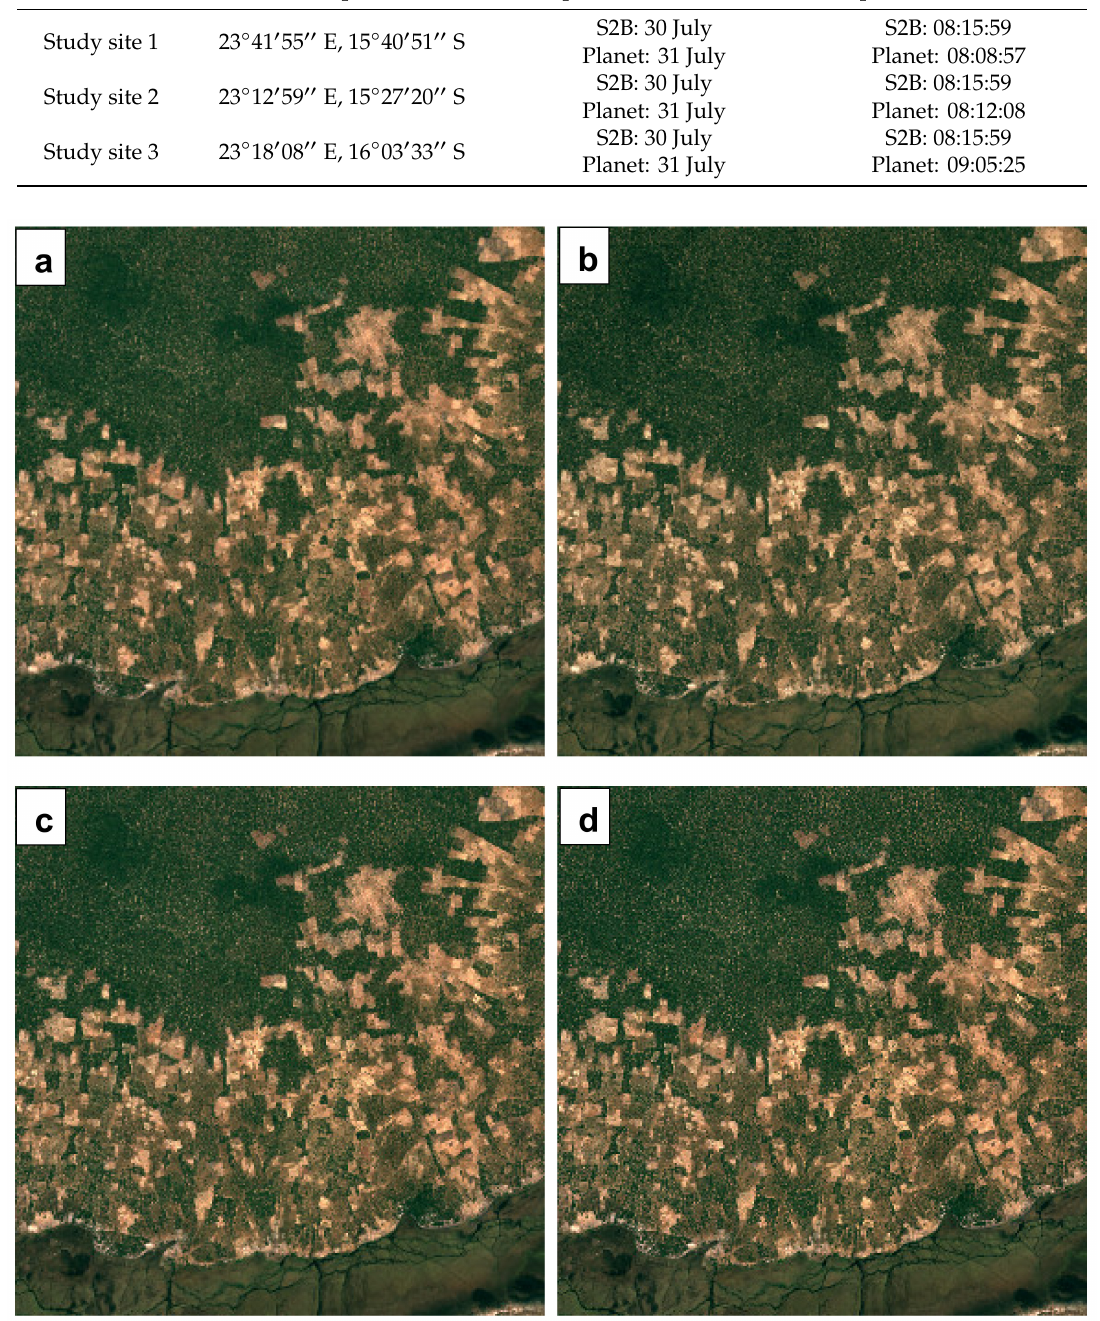
Figure 1. Study site 1 true color (red, green, and blue) surface reflectance images, composed of 1800 × 1800 3.333 m pixels covering 6 × 6 km ( a ) Sentinel-2 reflectance bilinear resampled from 10 m, ( b ) Planetscope reflectance, ( c ) Sentinel-2 HPM sharpened from 10 m, and ( d ) Sentinel-2 M3 sharpened from 10 m. Images oriented with north at the top of the image. Site and image dates summarized